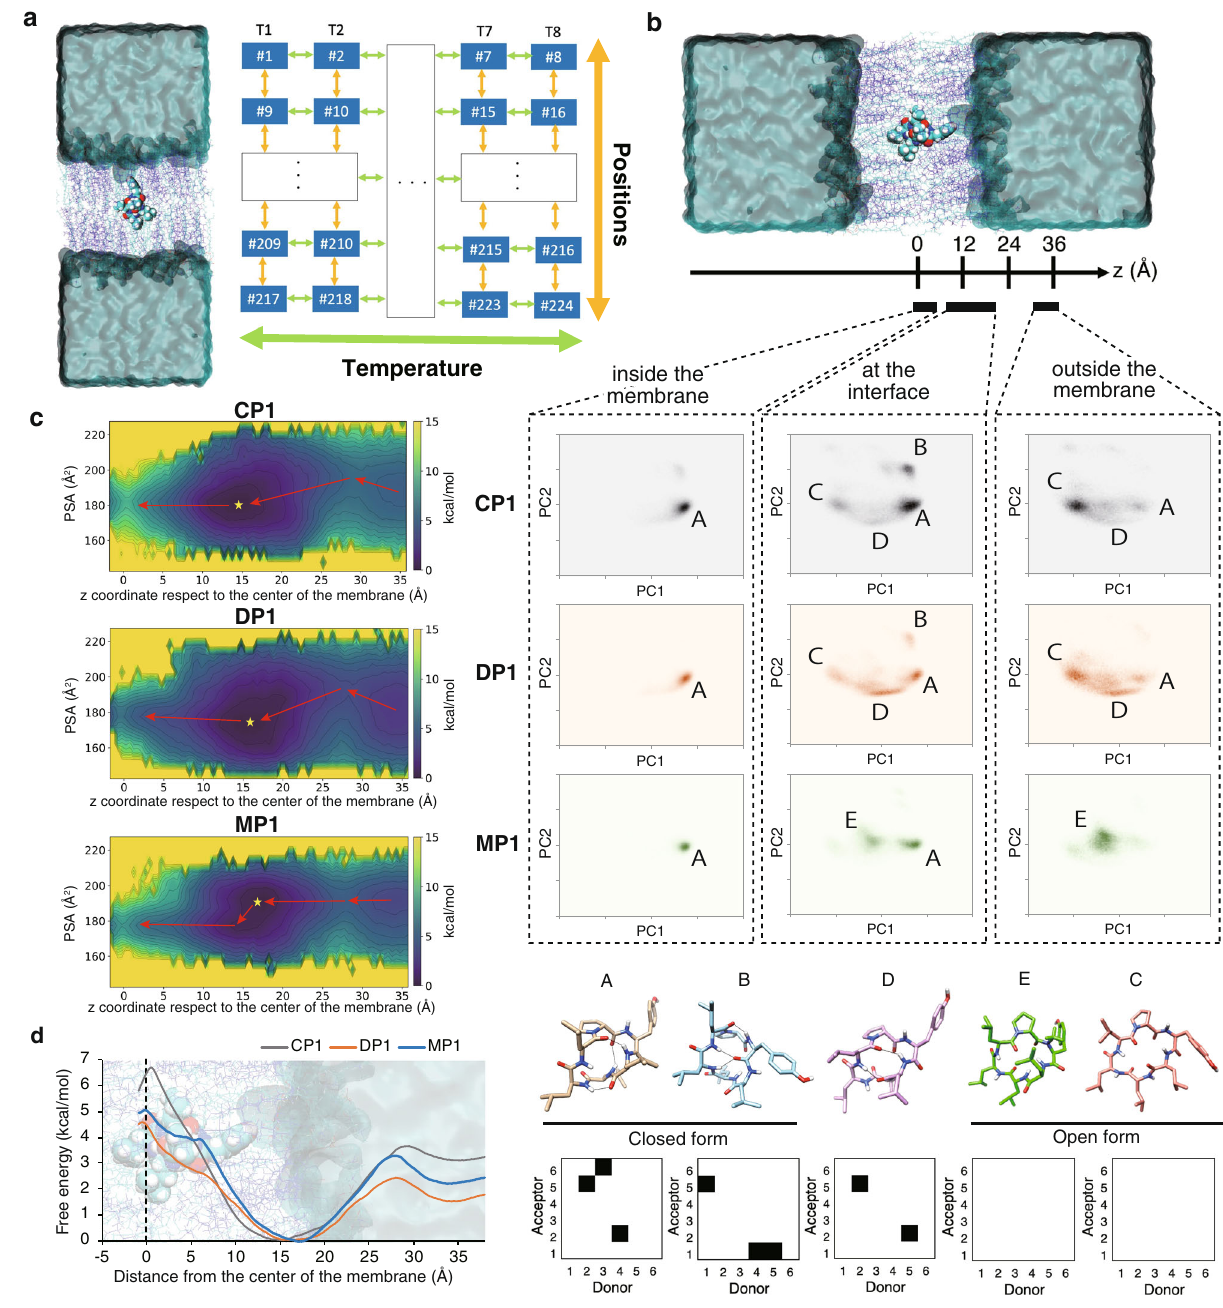
Fig. 4 | Enhanced sampling MD simulations of the membrane permeation process of CP1, DP1, and MP1. a Graphical abstract of the MD simulations. b Conformational ensembles of CP1 , DP1 , and MP1 inside, at the interface, and outside the lipid membrane projected onto the fi rst and second principal com- ponents(PC1andPC2),andrepresentativeconformationsandbackbonehydrogen